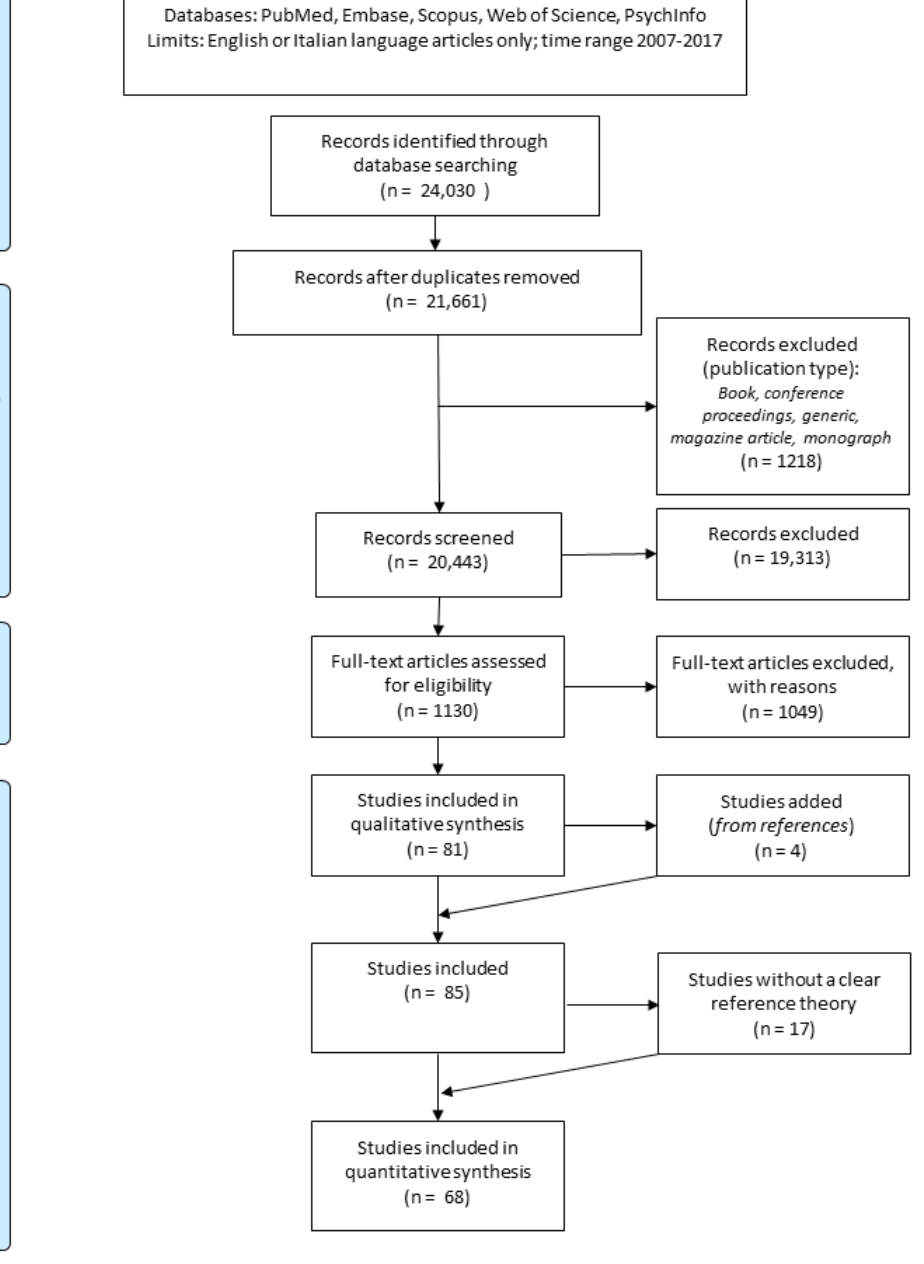
Figure 1. Prisma flow